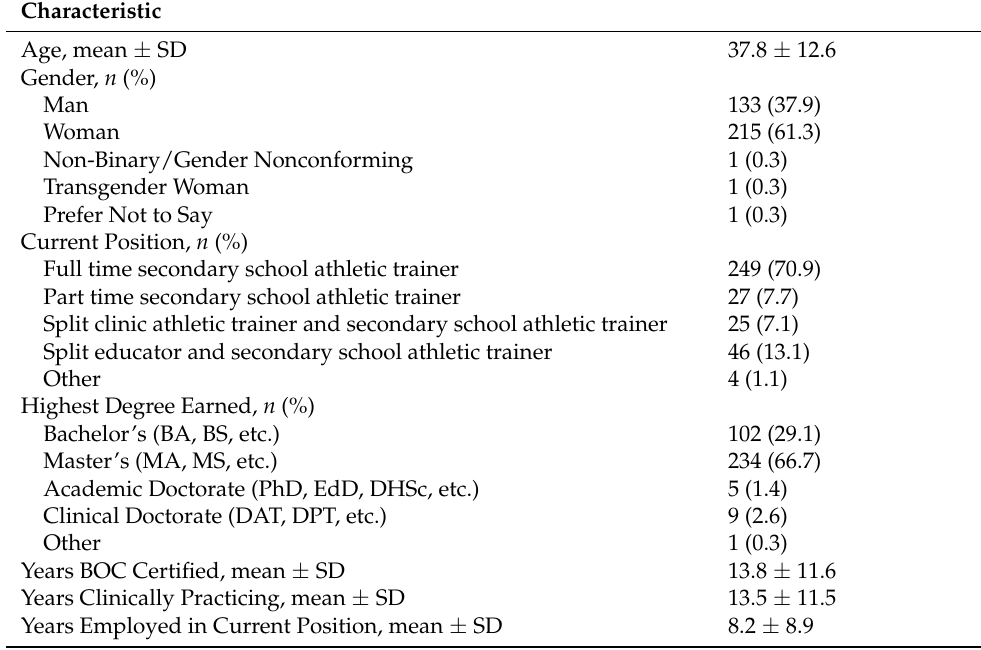
Table 2. Participant